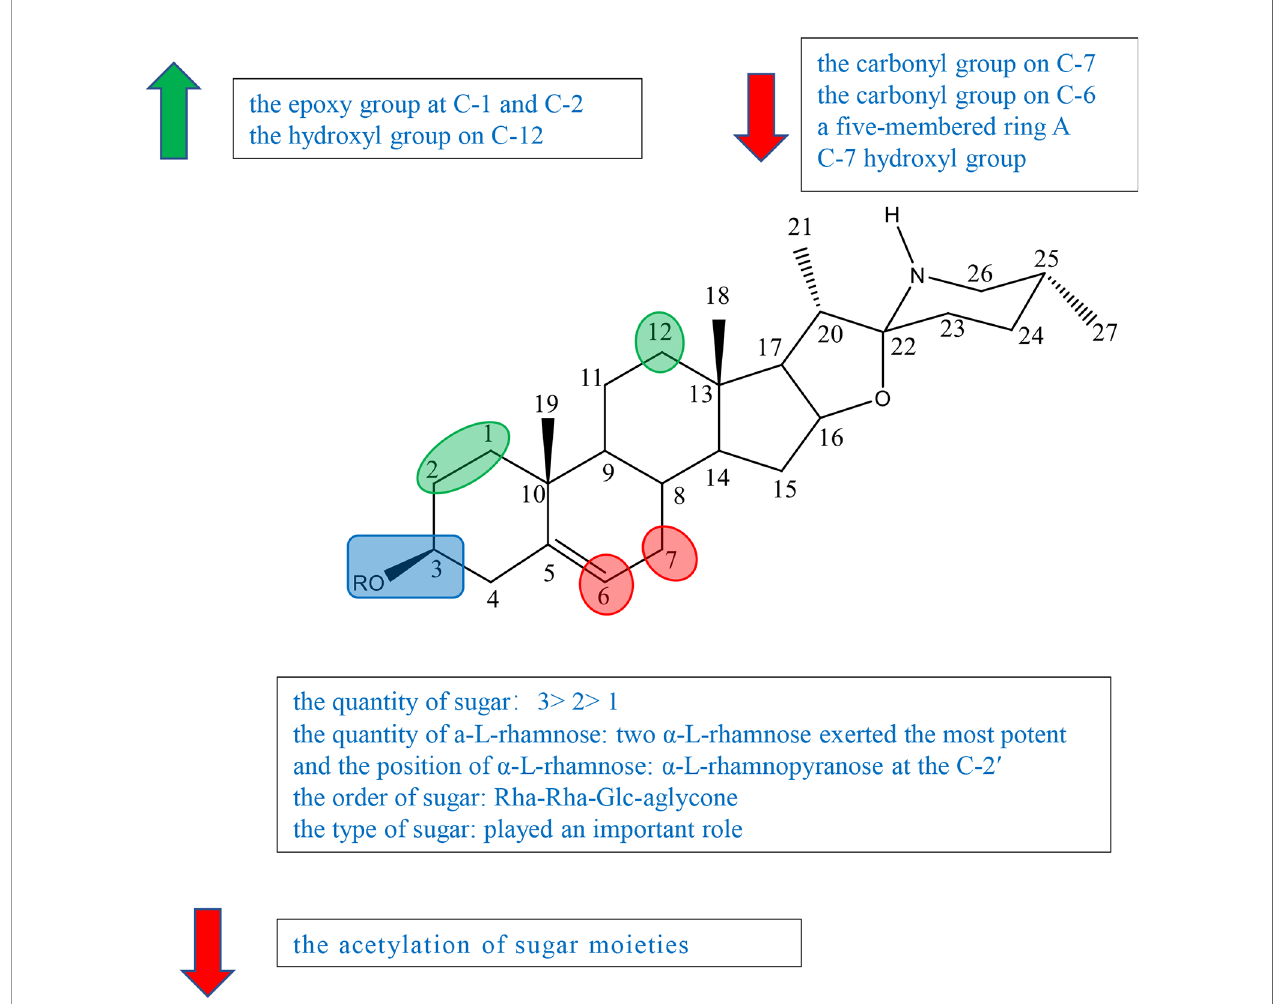
FIGURE 4 | Summary of Structure-activity Relationship of Cholestane Alkaloid — Solasodine